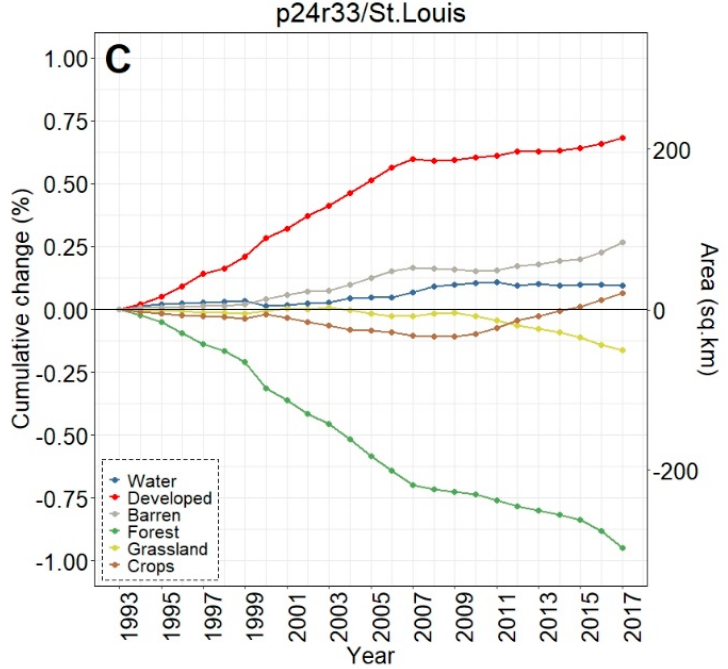
Figure 3. Cumulative footprint-level LULC change, both in percentage and approximate area, between the period 1993–2017 for ( A ) Chicago, ( B ) Peoria, and ( C ) St. Louis footprints. Our areal analyses throughout were calculated on pixel-change; we did not use a reference classification [61]. Note the differences in y-axis values across panels A–C.